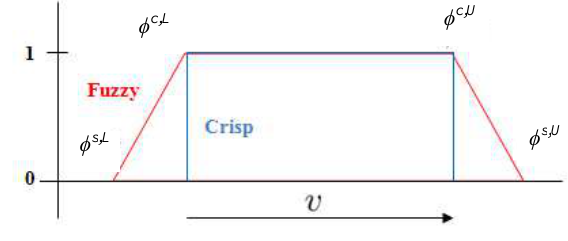
Figure 3. Crisp boundaries vs. Fuzzy boundaries